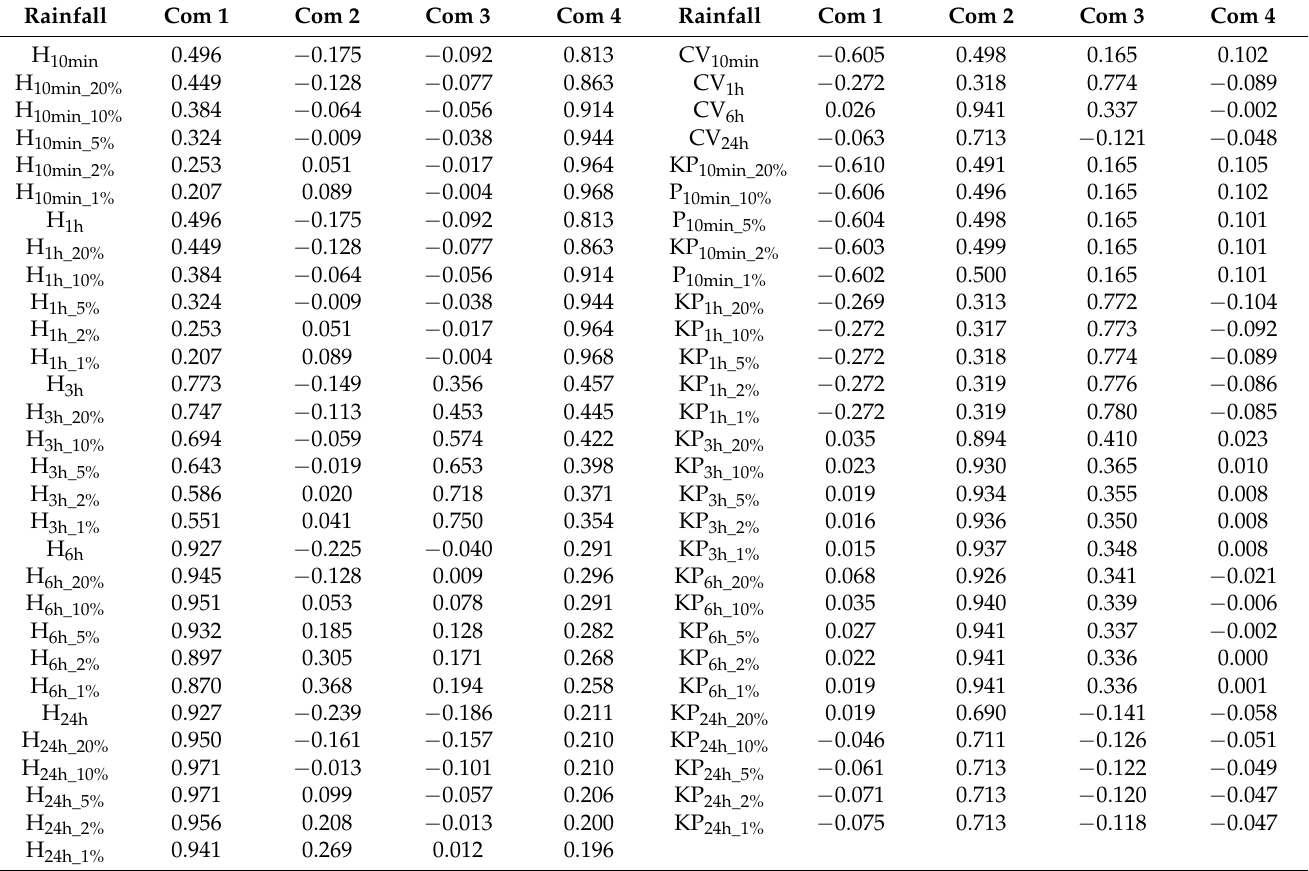
Table 6. Analysis Results for Rainfall